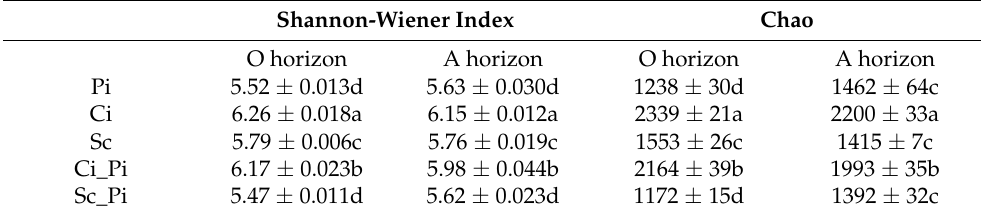
Table 1. Soil bacterial diversity in five types of forests.